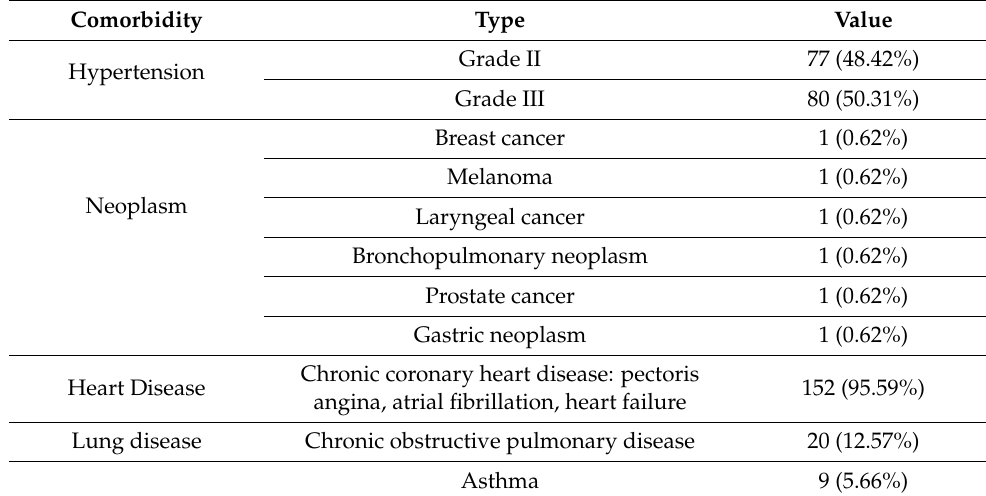
Table 2. Associated comorbidities.